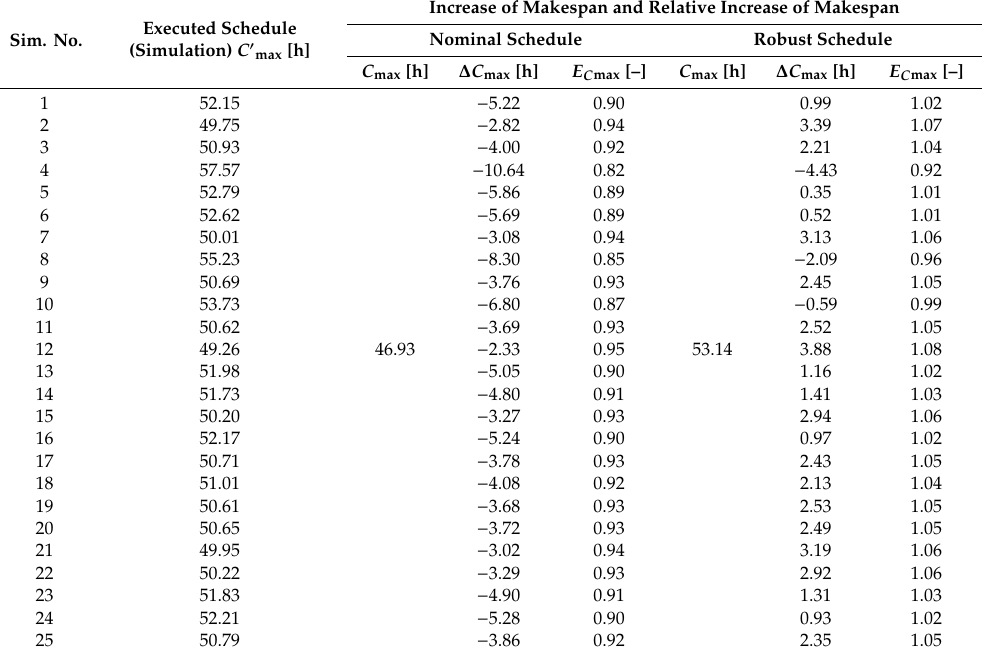
Table 9. Results from simulation: nominal and robust schedules (LPT—longest processing time).